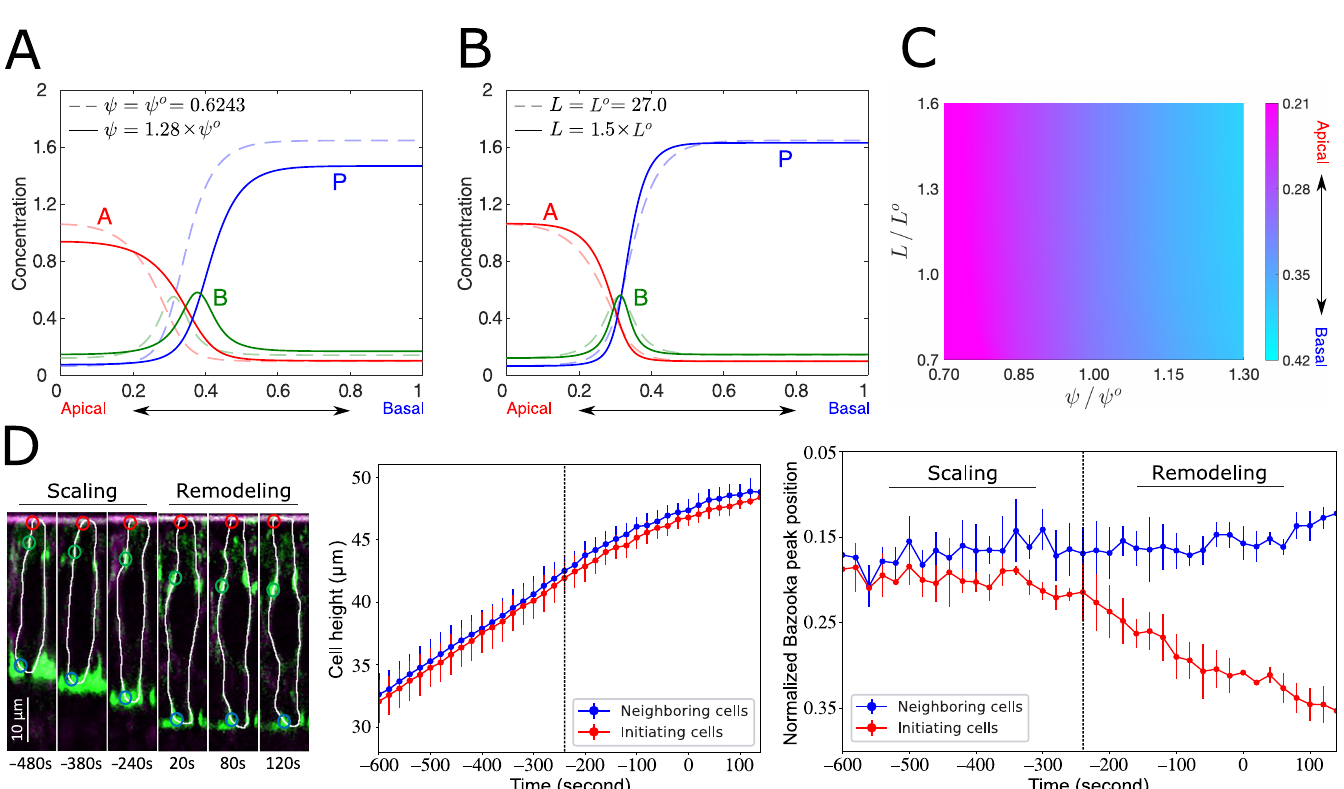
Fig 3. Cell geometric features affect membrane distribution of the polarity regulators. (A, B) The Bazooka peak position at the steady state (solid line) shifts basally following an increase in ψ (A), whereas it remains unchanged when L is increased (B) as compared to the control (dashed line). (C) Color plot of the Bazooka peak positions as a function of fold change of ψ and L . (D) (Left) Time-lapse images of a representative initiating cell outlined in white in the embryo expressing E-Cadherin- 3xGFP, Myosin-GFP and Gap43-mCherry. The red, green, and blue circles label the apical, junctional, and basal points, respectively, for quantification of the cell height and the Bazooka peak positions. (Middle) Time series of cell height averaged over the initiating (red) or neighboring cells (blue). (Right) Time series of Bazooka peak positions for both the initiating (red) and the neighboring cells (blue). In the middle and right panels, the vertical dash lines are plotted manually, serving as visual guides for the boundary between the scaling and remodeling phases. The bars of each data point are the standard deviation of the datasets derived from three embryos. See details of experimental setup and quantification method in Materials and methods.